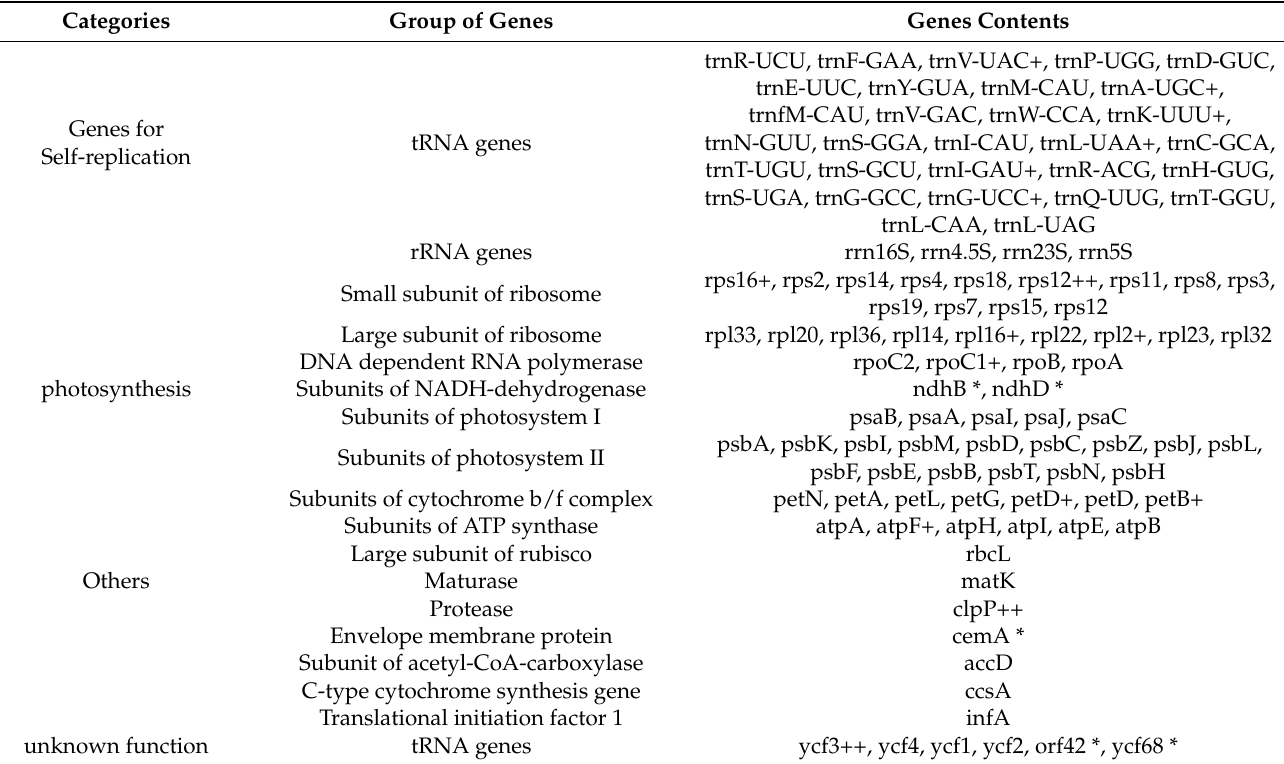
Table 2. Genes encoded in the five Paphiopedilum chloroplast